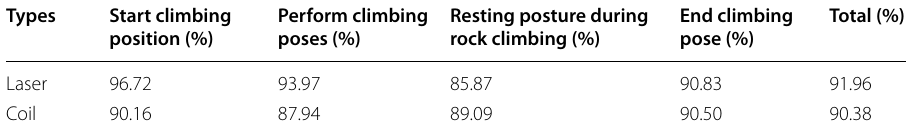
Table 5 Single-type feature test results Types